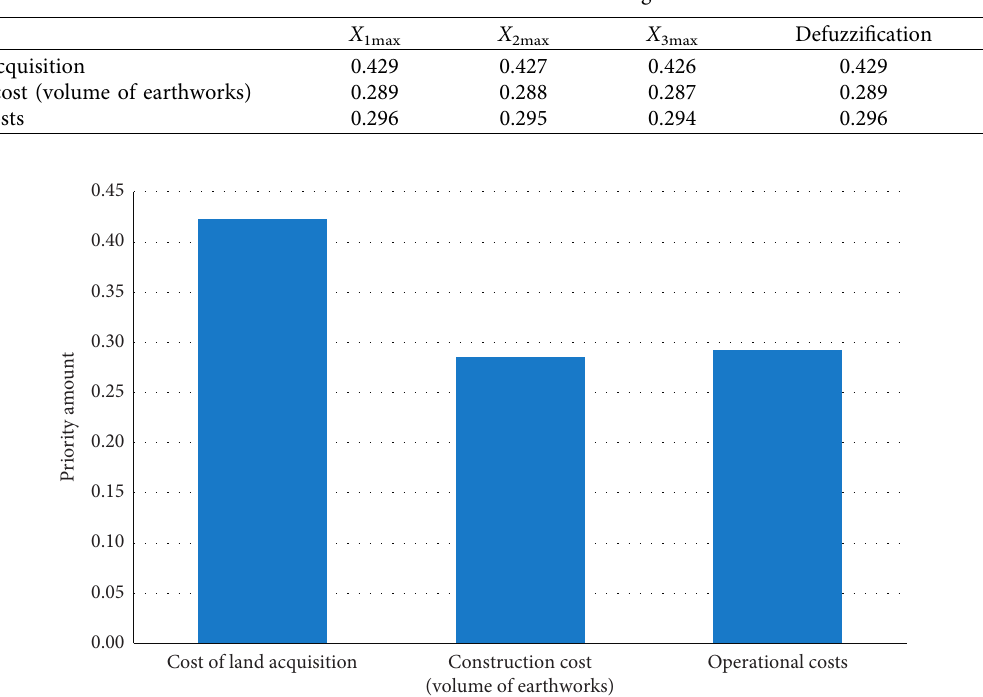
Figure 7: Display of the prioritization of economic